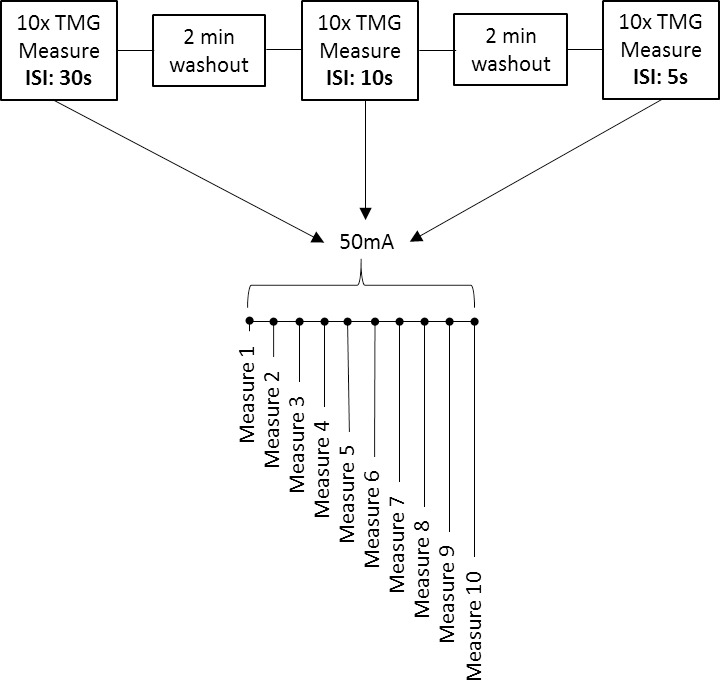
Experiment 2 timeline.Effect of changing inter-stimulus interval on Dm and Tc. Abbreviation: ISI, inter-stimulus interval.